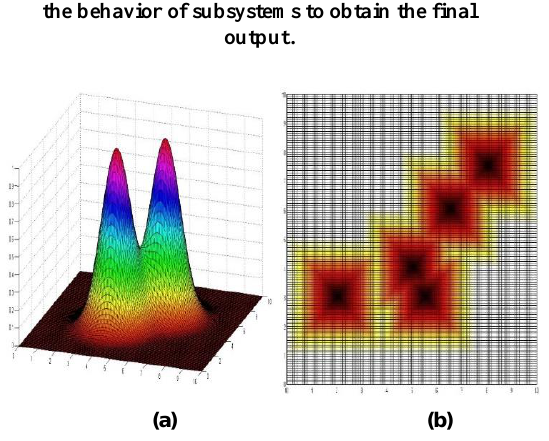
Figure 2. a) Ink stains with pyramid shape b) Five Inks are diffused on the